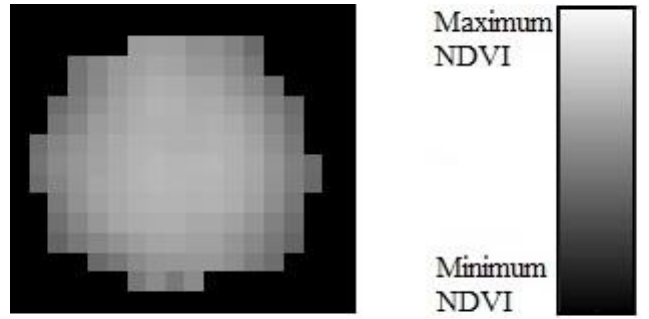
Figure 7. Distribution of image pixels in terms of greenness or NDVI values in an individual plant.